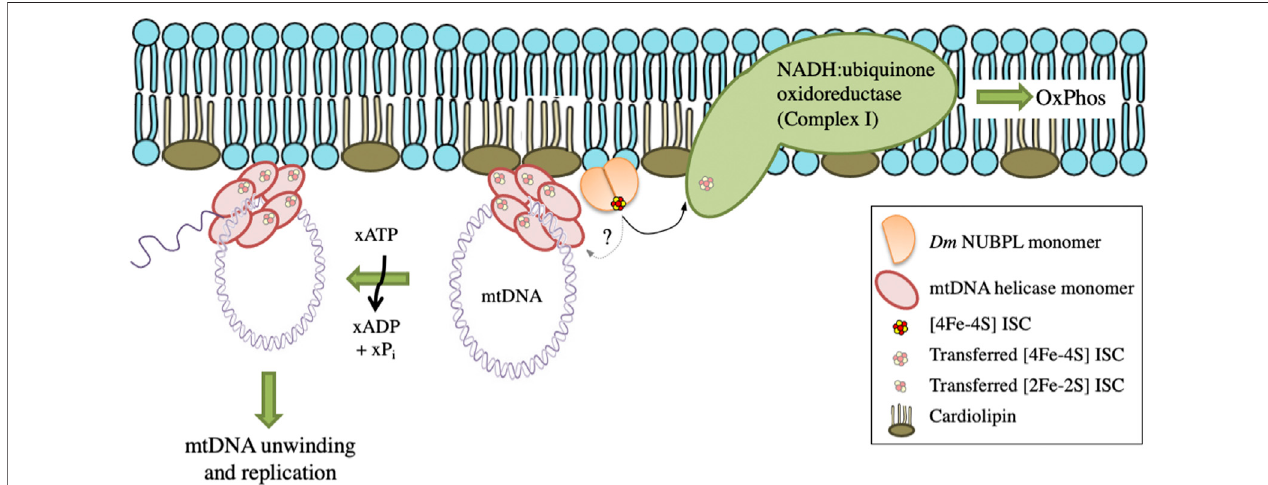
FIGURE 7 | A proposed model for the transfer and importance of ISC in genome stability. Dm NUBPL is a peripheral mitochondrial inner membrane protein responsibleforthetransferof[4Fe-4S]ISCtoNADH:coenzymeQoxidoreductase(complexI)ofthemitochondrialrespiratorychain.ThetransferofISCisrequiredforan ef fi cient oxidative phosphorylation and energy production. Similarly, Dm NUBPL docks to the membrane and transfers an ISC to the N-terminal domain of the mitochondrial helicase which stabilizes the protein and enhances its ATPase activity thus contributing to enhanced mtDNA